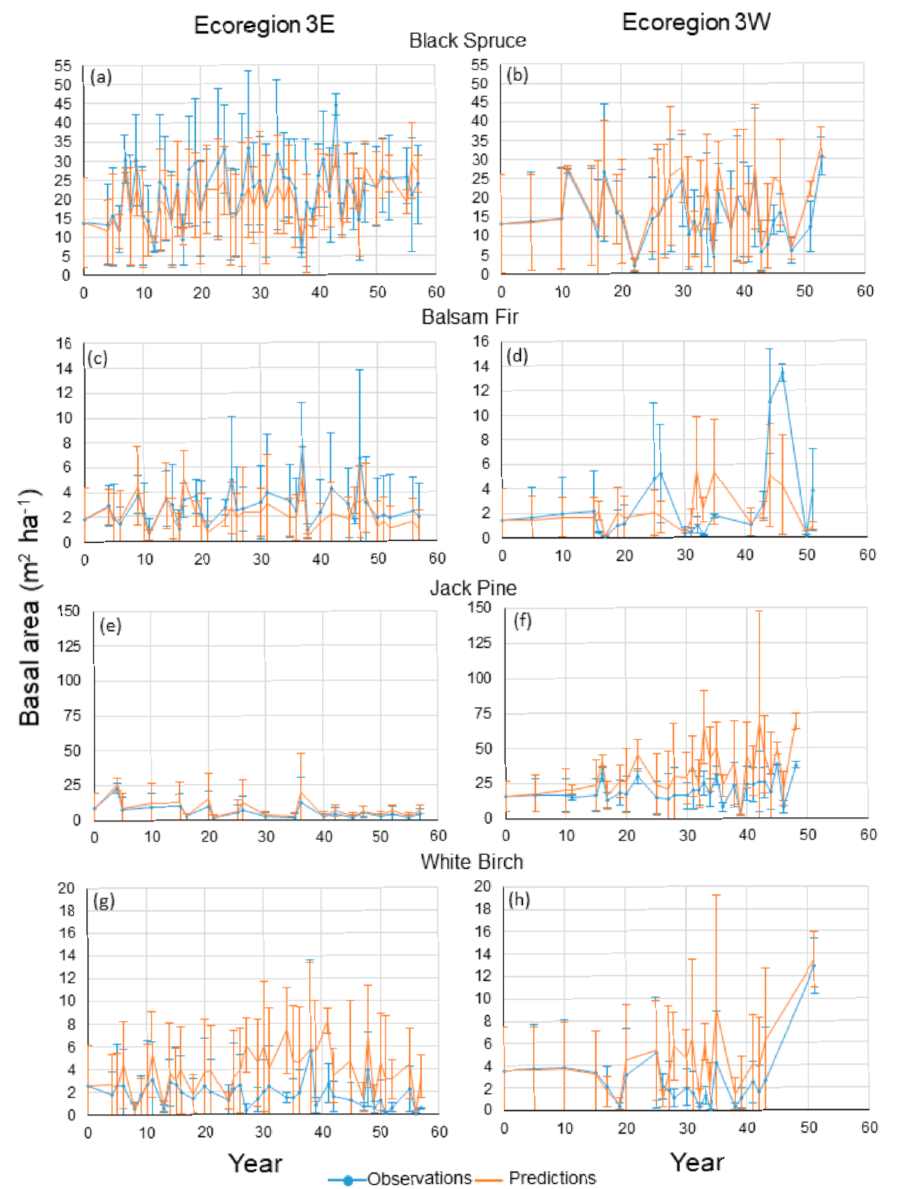
Figure 2. Comparisons between mean observed and predicted basal areas for black spruce ( a , b ), balsam fir ( c , d ), Jack pine ( e , f ) and white birch ( g , h ) over years in ecoregions 3E and 3W of the boreal forest region of northern Ontario, Canada. Error bars are standard